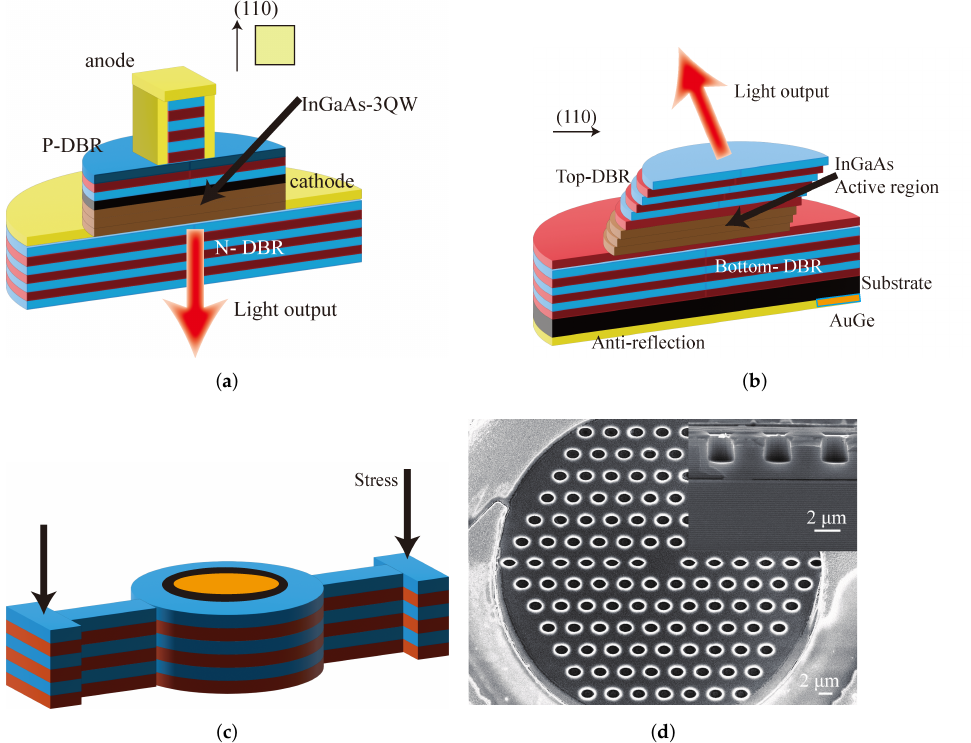
Figure 8. Anisotropic loss VCSEL ( a ) schematic cross-sectional layout of the VCSEL with rectangular column [64]; ( b ) schematic cross-sectional layout of the VCSEL with tilt column [67]; ( c ) schematic drawing of the VCSEL with the oxidized “T-bars” [68]; ( d ) SEM images of the fabricated photonic crystal VCSEL